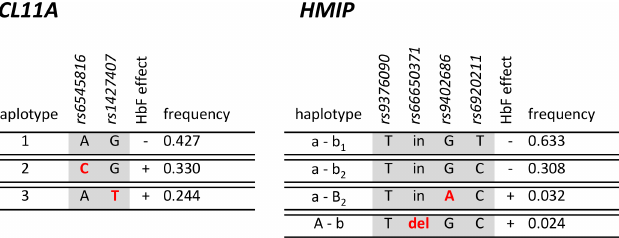
Fig 3. Haplotypes of genetic variants detected at the BCL11A and HMIP loci. Red letters denote HbF-increasing alleles. HMIP haplotypes were named to match the locus architecture described previously [16, 26]. A situation with two HbF-raising variants in cis, i.e. occupying the same haplotype, was not